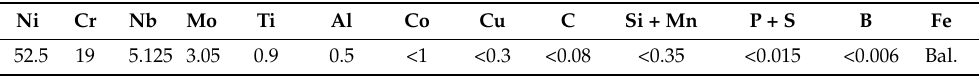
Table 1. Chemical composition in weight percent of the employed gas atomized powder.